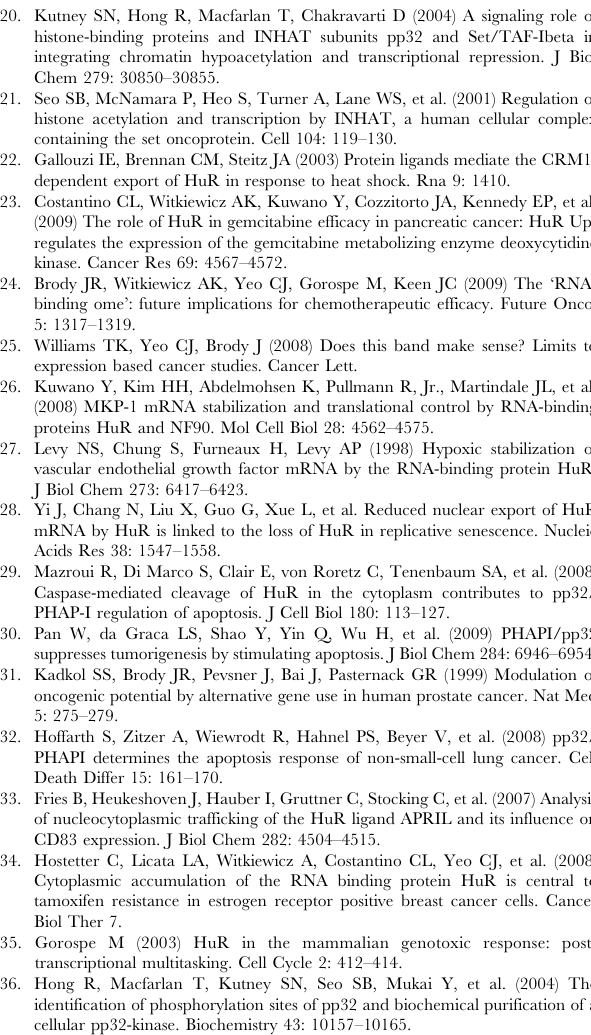
Figure S1 RNP IP assay to measure the association of dCK mRNA with HuR in Mia.pp32 cells. RNA